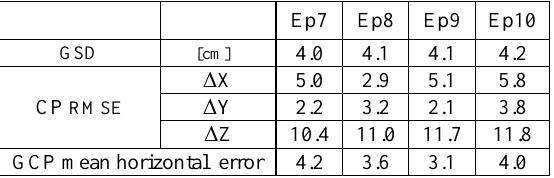
Table 3. CPs and GCPs RMSE results for Reference Ground Control Point- based co-registration (Epochs 7-10).